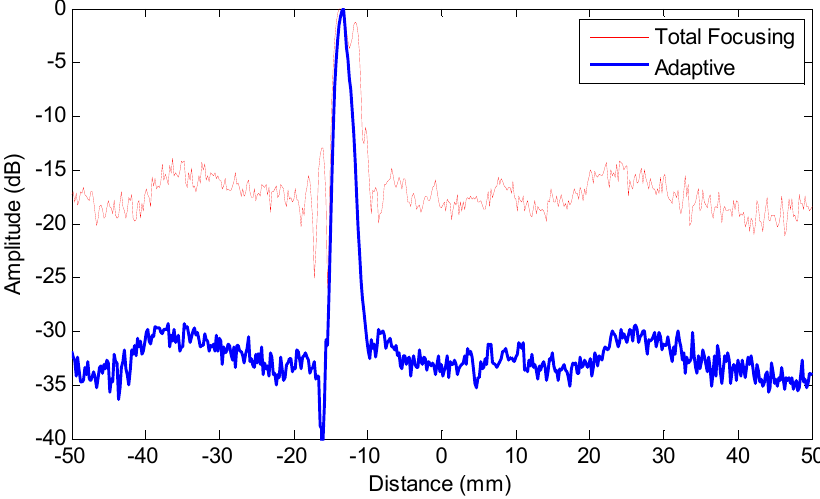
Figure 11. Lateral profiles of experimental images at range of 52 mm. Red solid line: total focusing method, blue bold line: adaptive